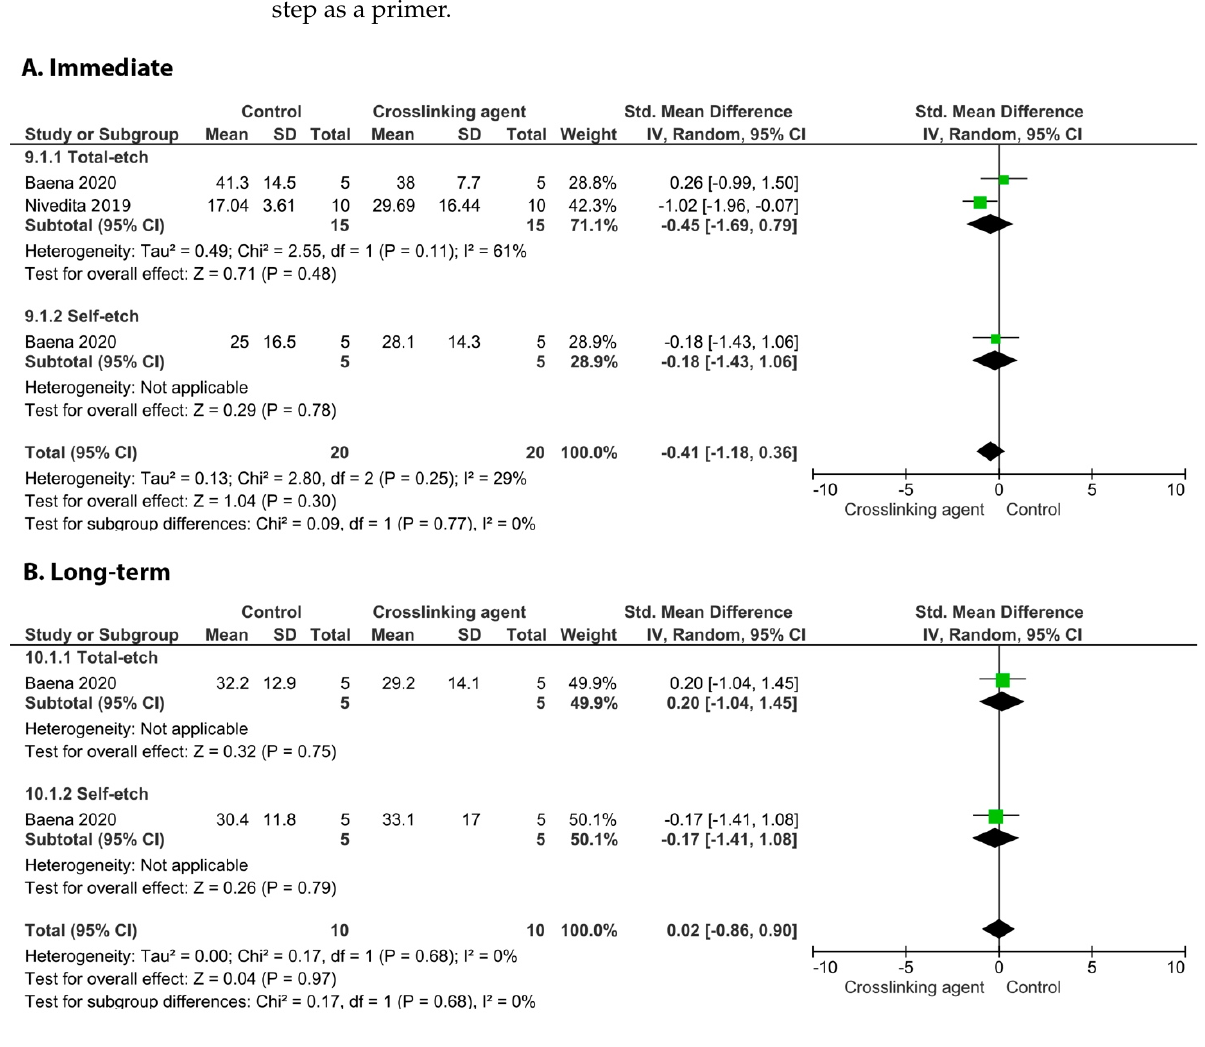
Figure 2. Forest plot of the immediate ( A ) and long-term ( B ) bond strength comparison between the chitosan crosslinking agent and the control according to the adhesive used, [107,123].